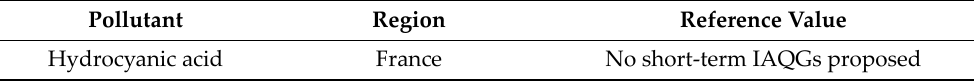
Table 25. Reference values for hydrocyanic